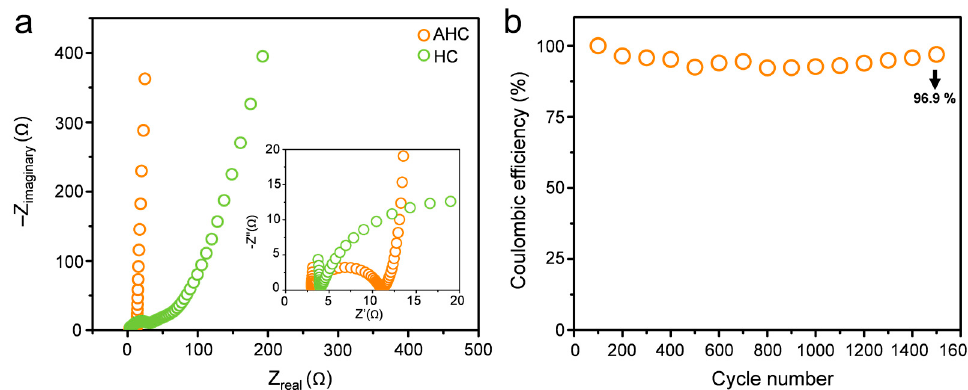
Figure 6. ( a ) Nyquist plots of AHC and HC at applied potential of − 0.4 V for AC amplitude of 10 mV in the range from 1 MHz to 10 µ Hz. ( b ) Cycle life of AHC electrode over 1500 cycles at current density of 0.3 A g − 1.